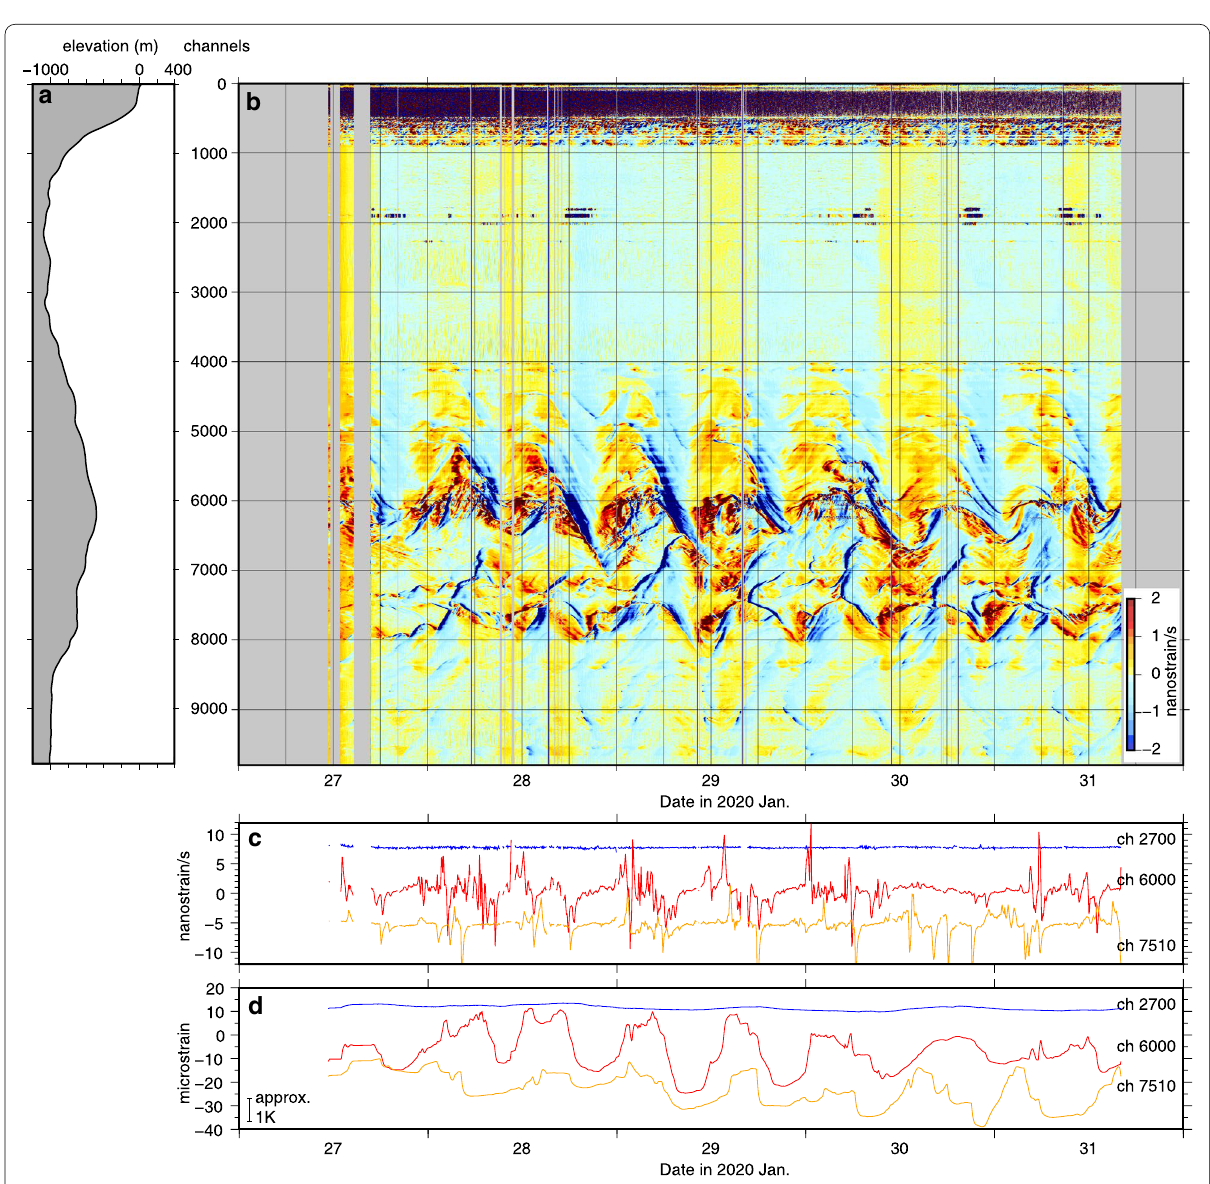
Fig. 5 Five-minute averages of the spatial and temporal changes in strain rate for the entire observation period. a Bathymetry profile along the cable route. b Space–time plot of the average strain rate (5-min interval) for the entire observation period. c Temporal changes in the average strain rate (5-min interval) at three selected channels. The traces have been shifted vertically for comparison. d Integration of the strain rate records shown in c . Note that the scale of 1 K includes a large uncertainty as explained in the